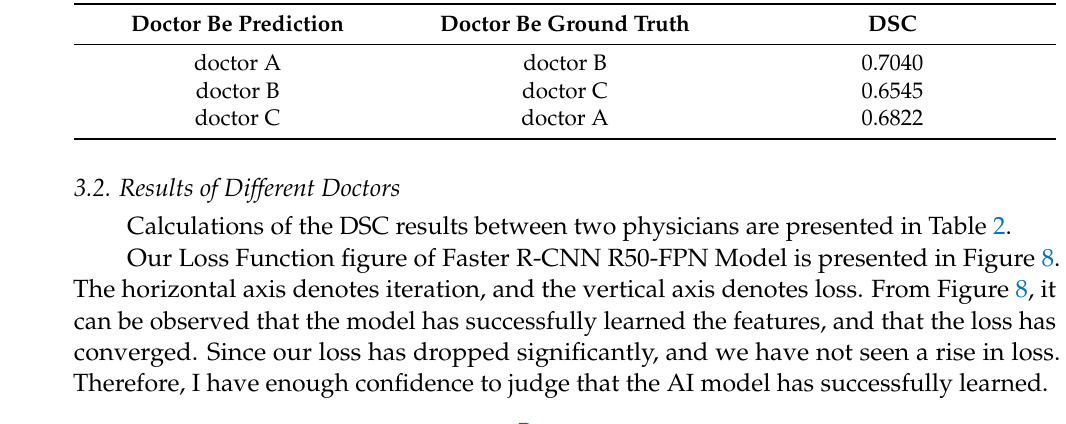
Table 2. The results of Different doctors.